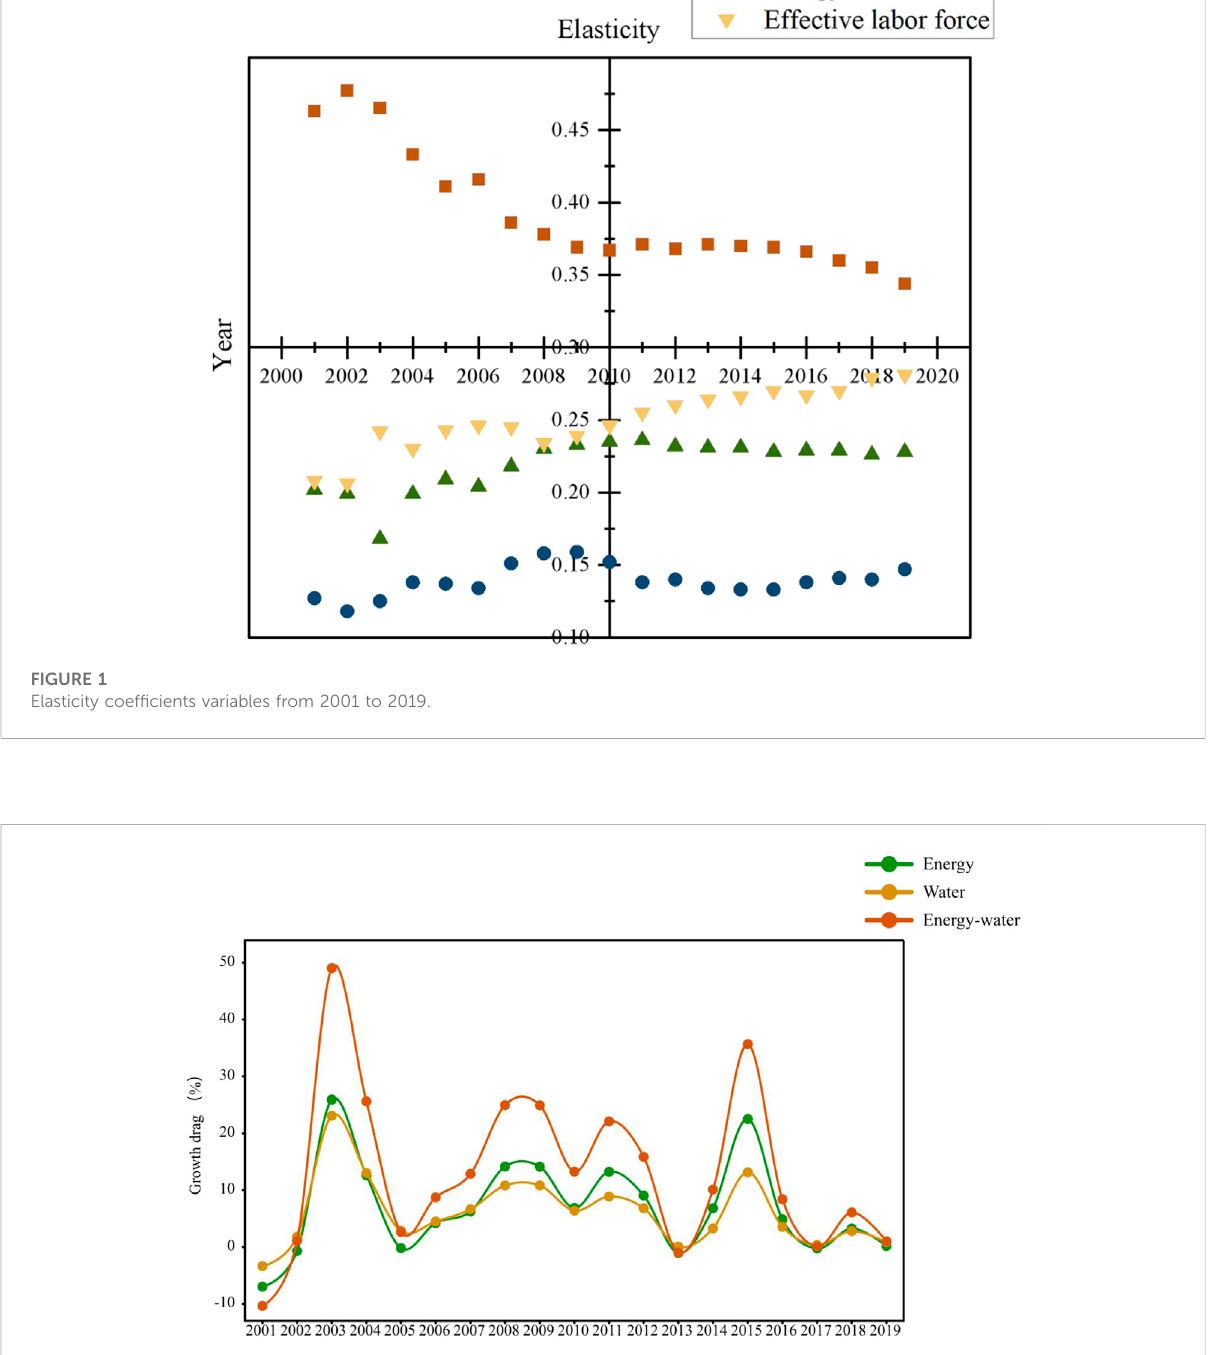
FIGURE 2 Drag effects of China from 2001 to